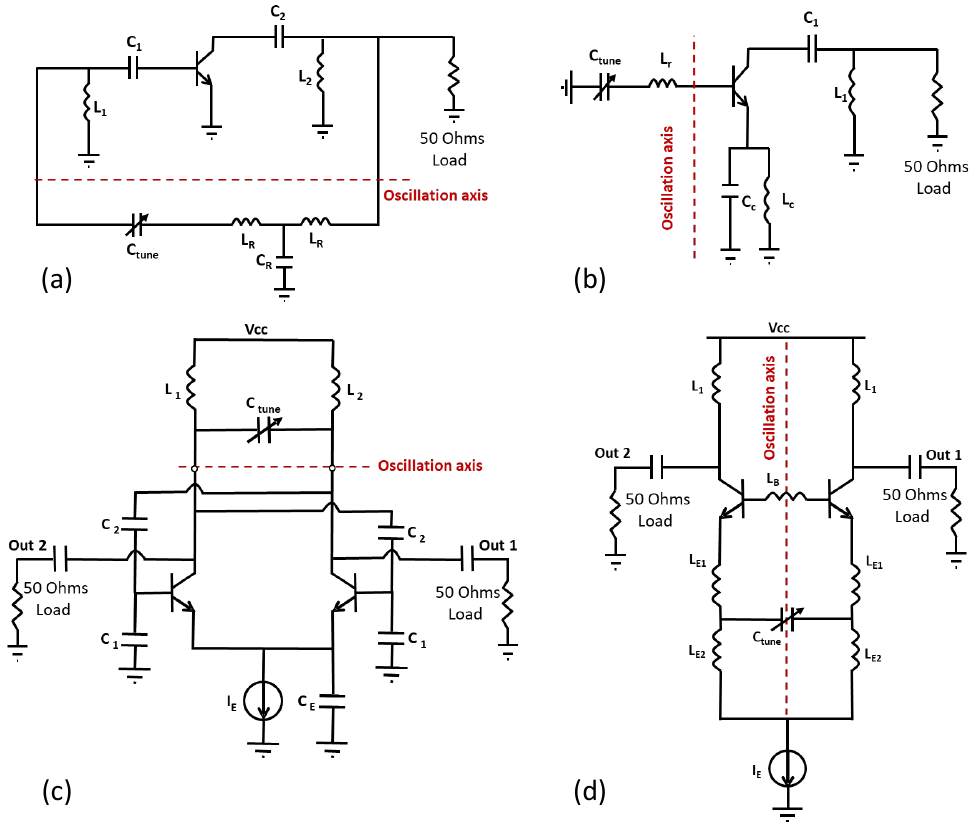
Figure 9. Main simplified topologies of HF oscillators with ( a ) parallel, ( b ) reflection, ( c ) crosscoupled, and ( d ) balanced push-push